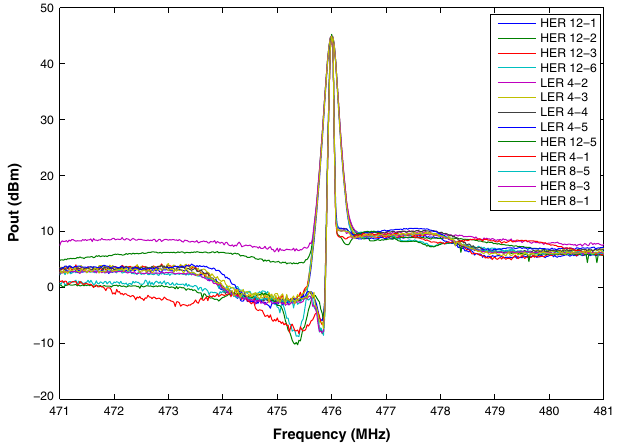
FIG. 22. (Color) Swept sideband image responses for 13 ampli- fiers ‘‘A’’ from